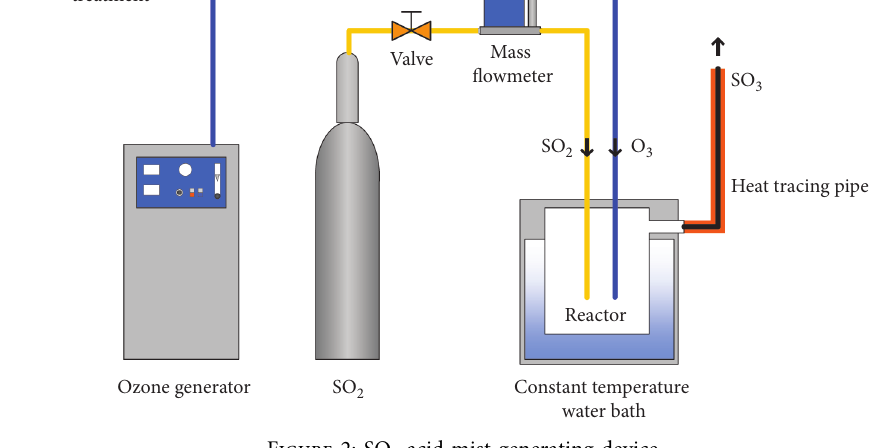
Figure 2: SO 3 acid mist generating device.